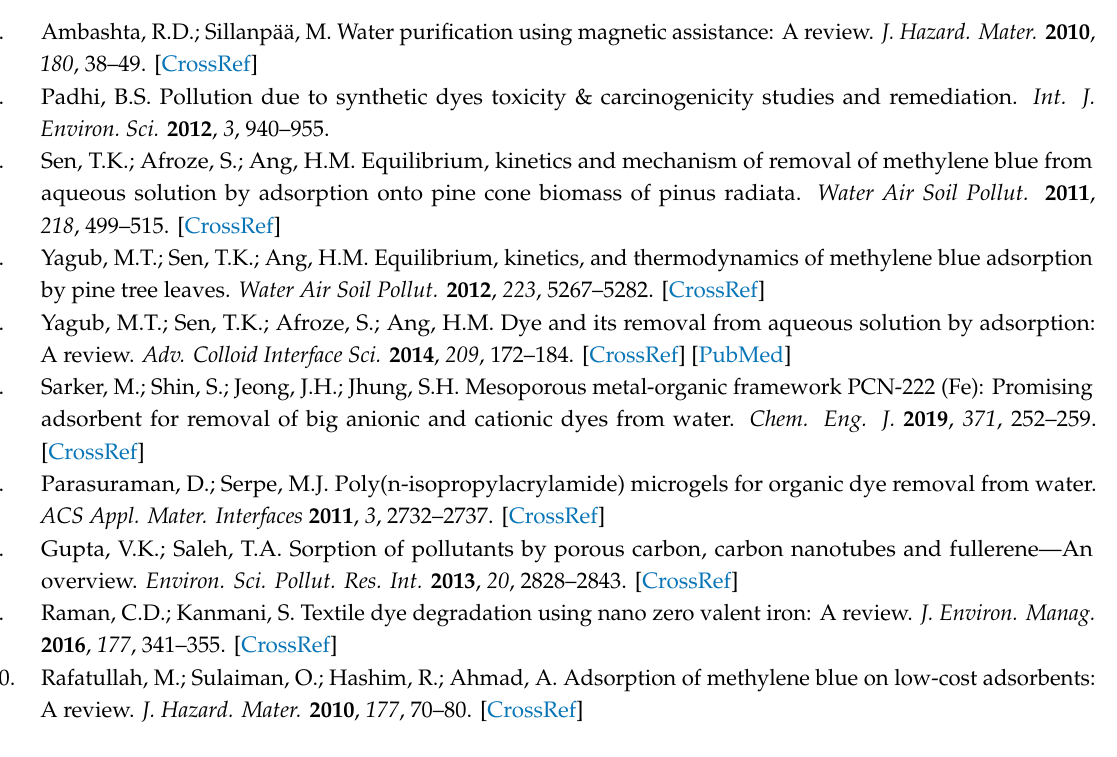
Figure S1: FTIR spectra of Zr-based MOF-545 (red) and Fe-loaded MOF-545(Fe). Figure S2: Testing the peroxidase-like activity of MOF-545(Fe). Figure S3: X-ray di ff raction (XRD) patterns of Fe-loaded MOF-545(Fe) reaction at di ff erent pH. Figure S4: X-ray di ff raction (XRD) patterns of Fe-loaded MOF-545(Fe) degrade TMB. Figure S5: Repeatability test of Fe-loaded MOF-545(Fe) for removal of MB and MO. Figure S6: X-ray di ff raction (XRD) patterns of Fe-loaded MOF-545(Fe) for removal of MB and MO reused eight times with adsorption. Figure S7: The experiment of Fe-loaded MOF-545(Fe) removed MB(A) and MO(B) by degradation. Figure S8: X-ray di ff raction (XRD) patterns of Fe-loaded MOF-545(Fe) for removal of MB and MO reused eight times by degradation. Table S1: Compare the peroxidase-like activity of Fe 3 + , TCPP-Fe and Zr-based MOF-545. Author Contributions: Research of designing, Z.L., C.L. and C.Z.; experimental operation, C.Z.; H.L. conducted the data analyses. Writing the draft and data preparation, C.Z. and C.L. All authors have read and agreed to the published version of the manuscript. Funding: This work was supported by the National Natural Science Foundation of China (grant number: